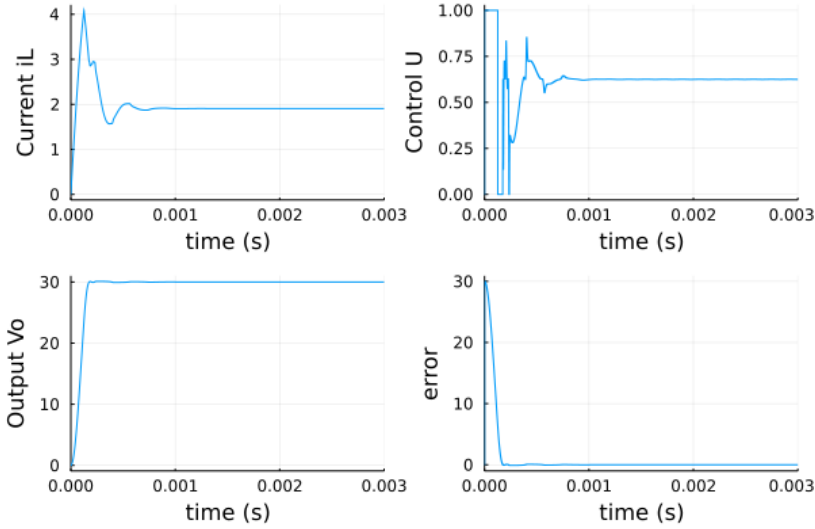
Figure 9. The output response of the Buck converter controlled by GAPID optimized by WOA: inductor current i L , output voltage V o , control signal U , and instant